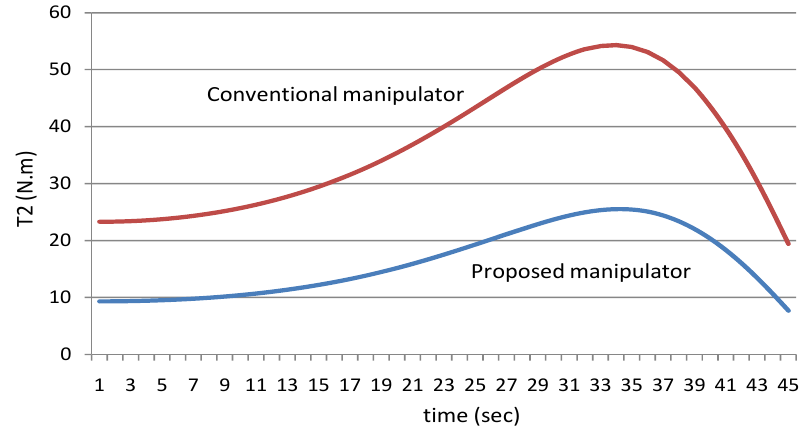
Figure 11. The values of the torques of the second joint using the both